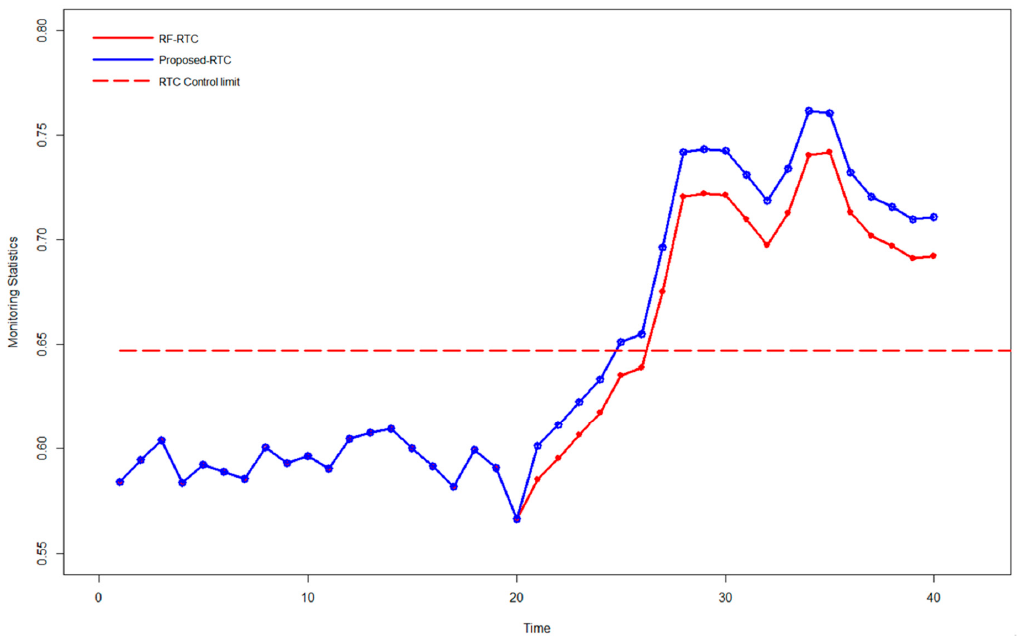
Figure 6. Comparison of monitoring statistics.